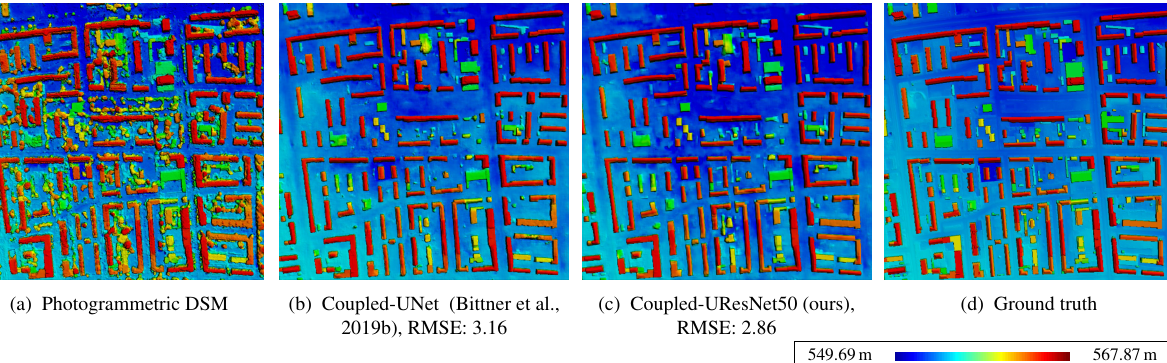
Figure 5. Visual analysis of DSMs, generated by (a) Coupled-UNet cLSGAN with fixed balancing hyper-parameters (Bittner et al., 2019b) and (c) by the proposed Coupled-UResNet50 in comparison to (d) referenced surface model over Munich area. (a) depicts the initial photogrammetric DSM. DSM images are color-shaded for better visualization.